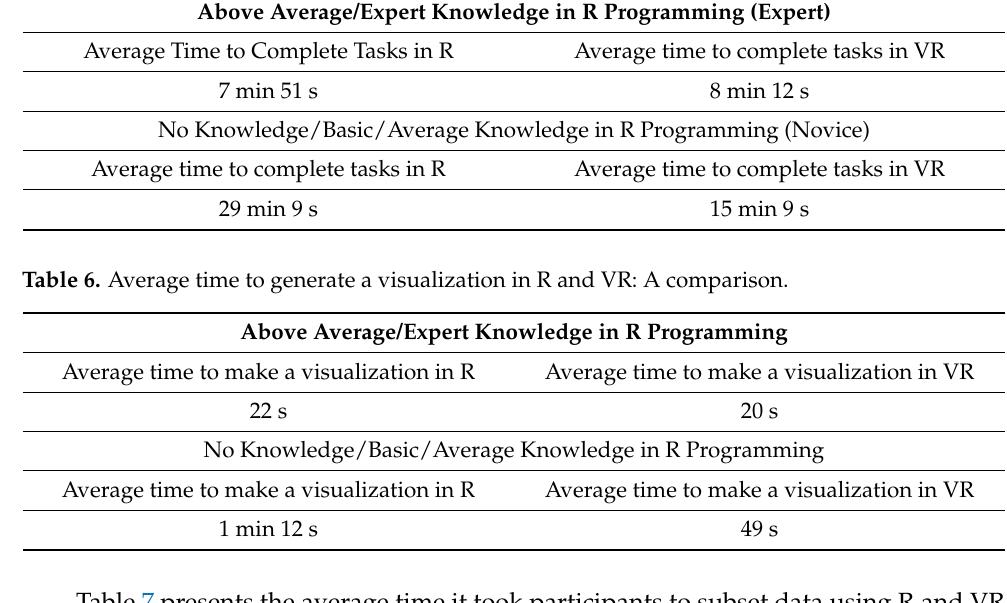
Table 5. Tutorial average completion time in R and VR: A comparison.